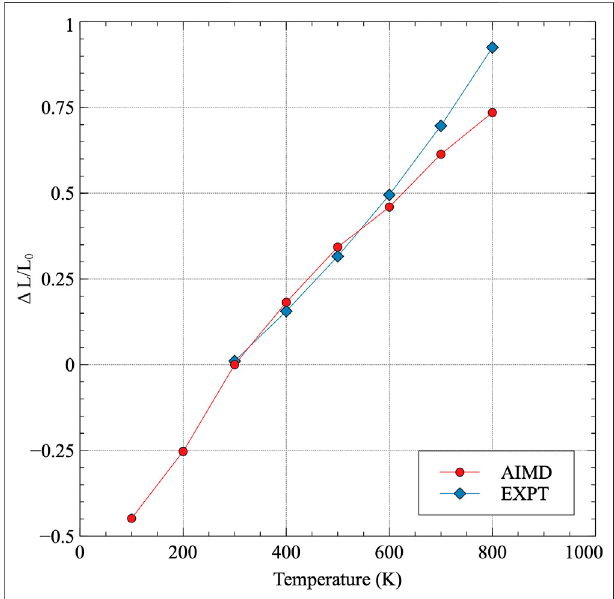
FIGURE 4 | Volume-averaged linear thermal expansion in α -U. Thermal expansion is taken with respect to 300 K and compared to experimental results Touloukian et al.